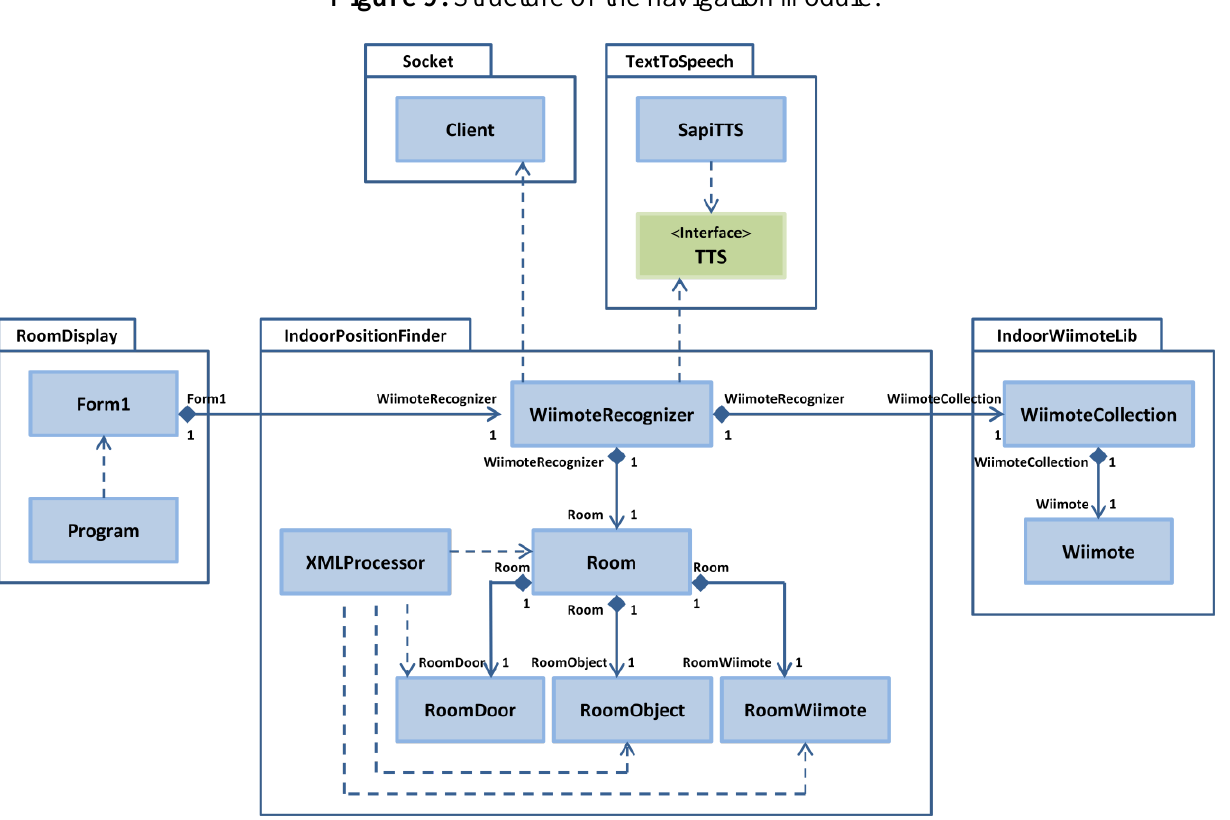
Figure 9. Structure of the navigation